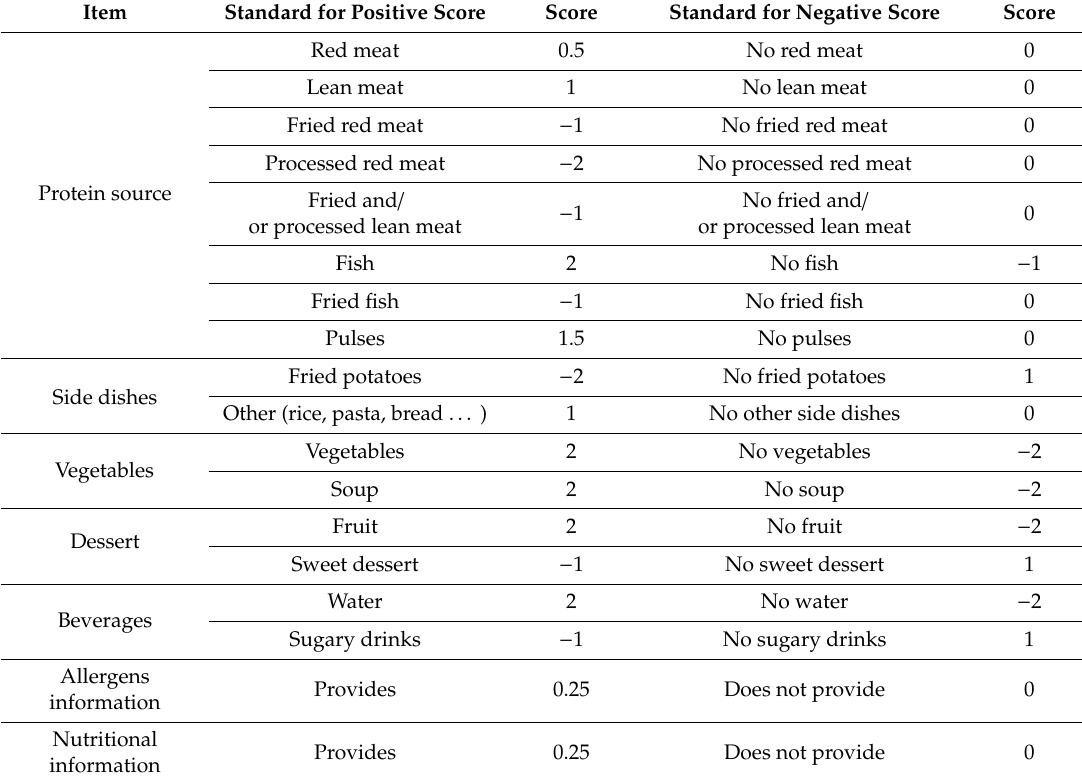
Table 1. Description of Kids’ Menu Healthy Score